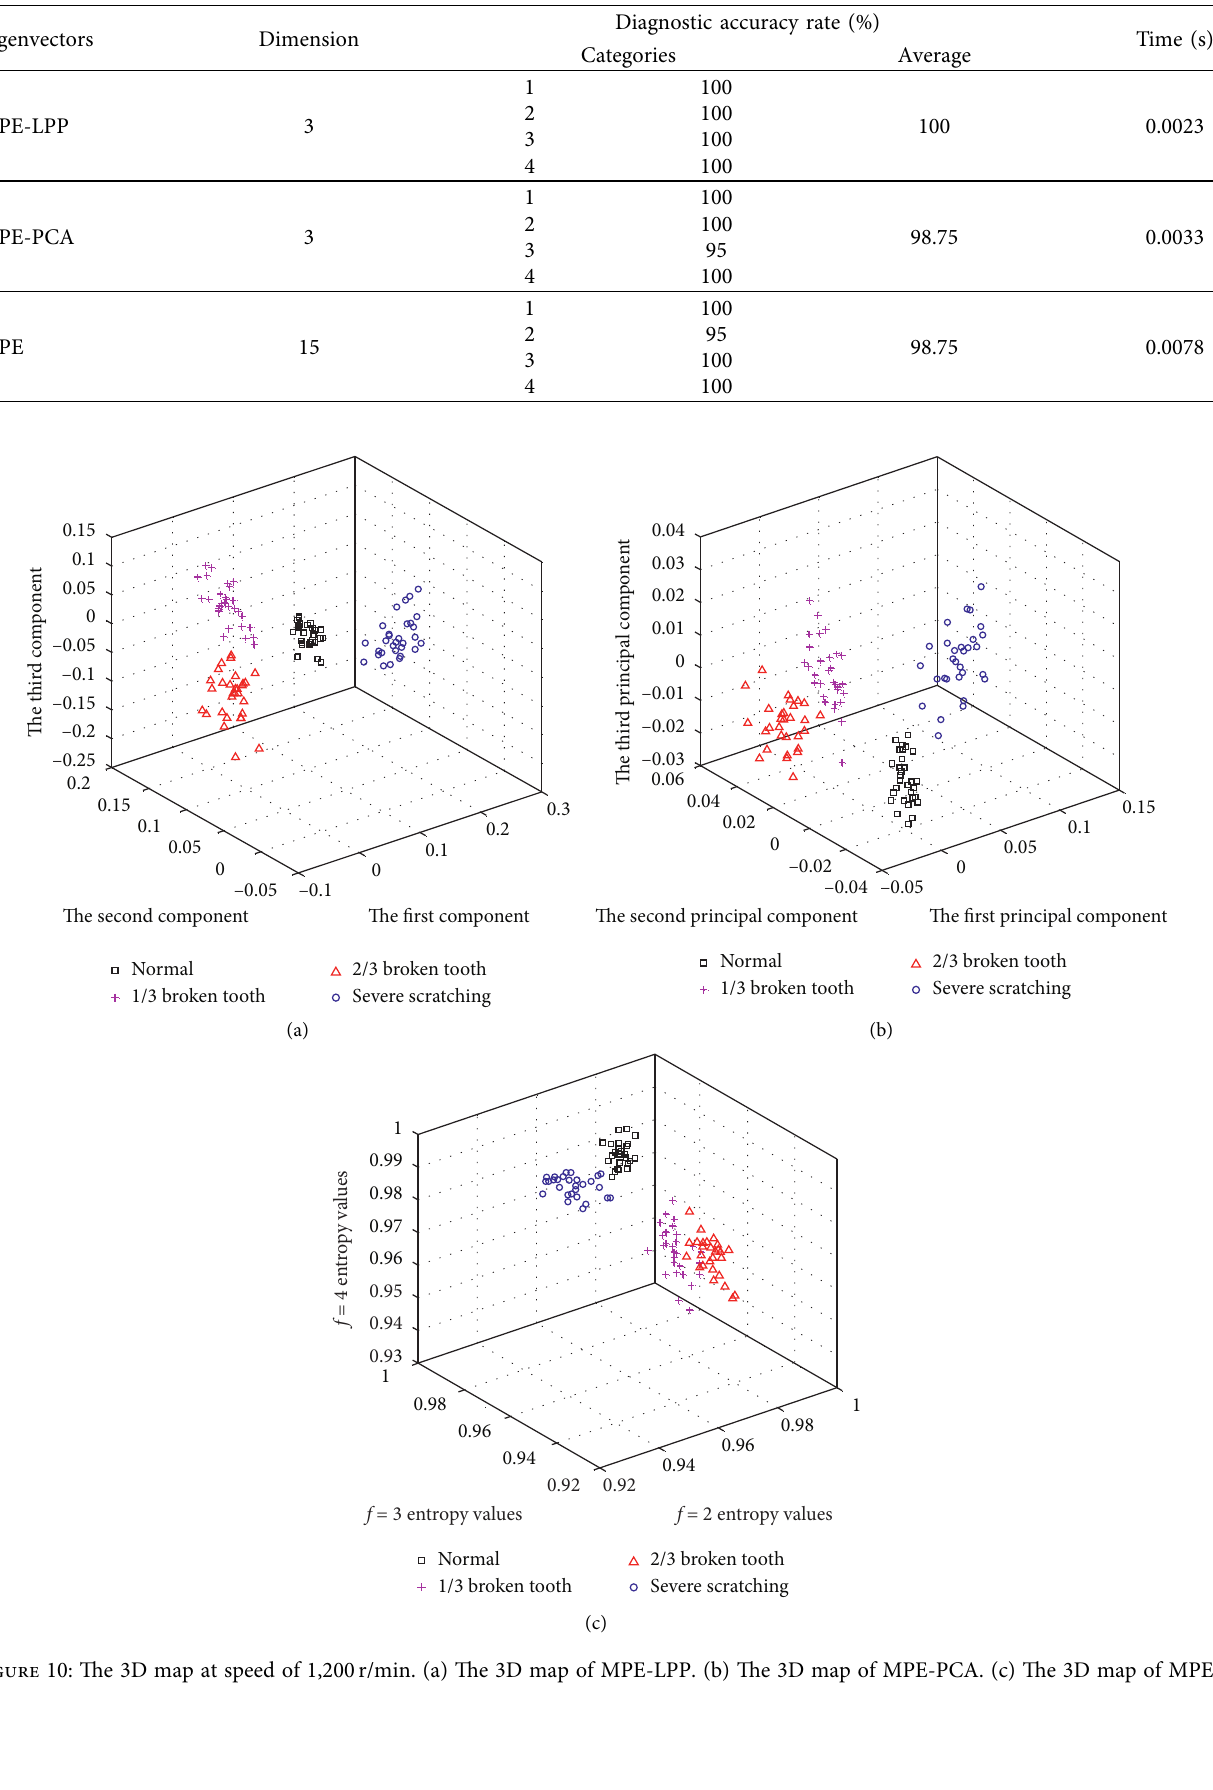
Table 2: ELM diagnostic results and identification time.